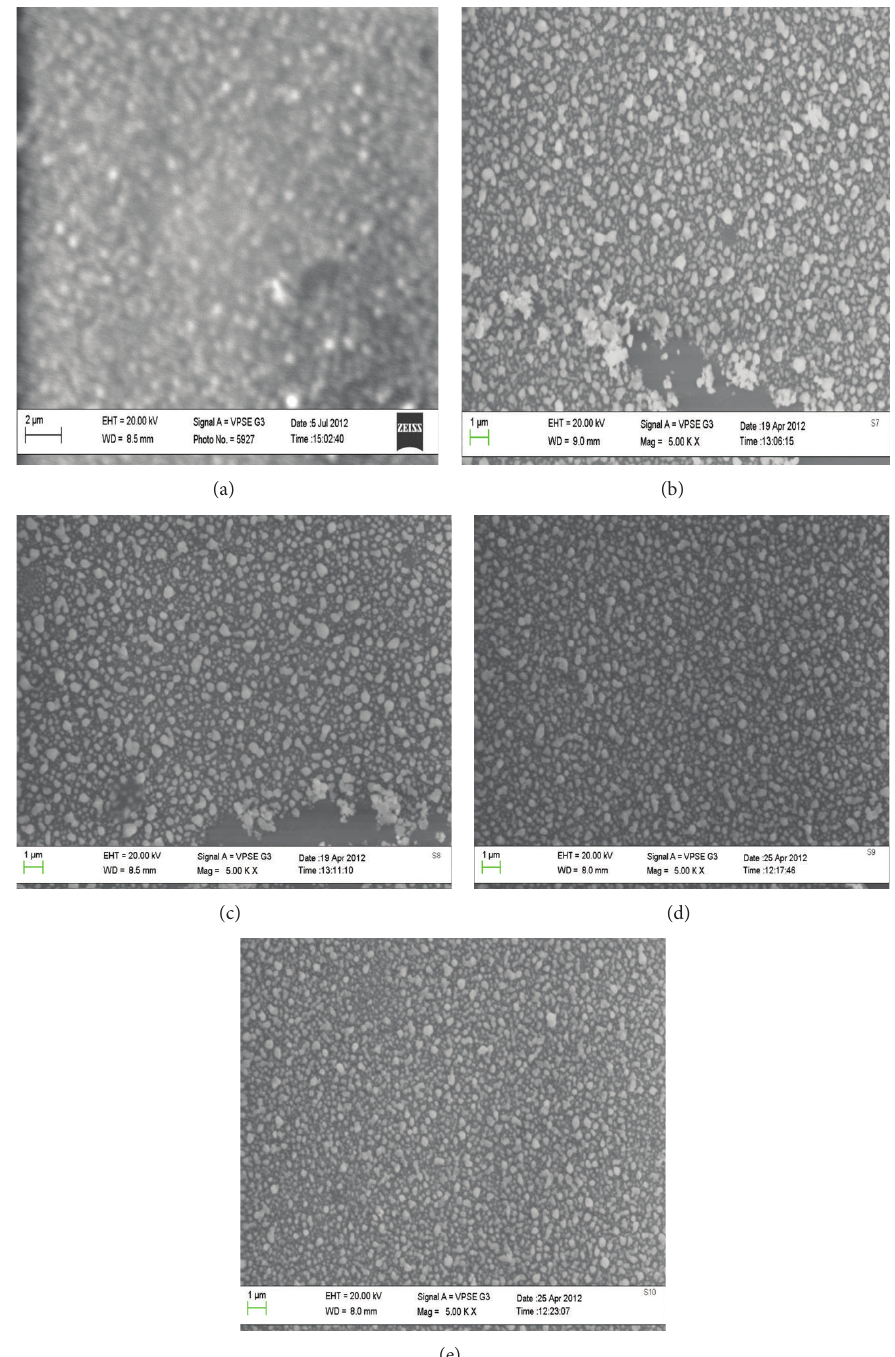
Figure 3: The SEM images of the deposited films after (a) 50 mins, (b) 60 mins, (c) 70 mins, (d) 80 mins, and (e) 90 mins.